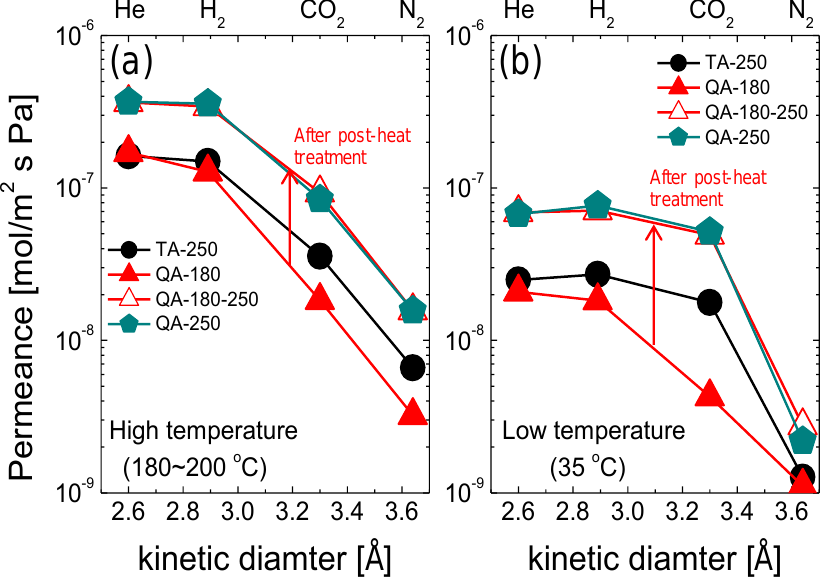
Figure 15. Kinetic diameter dependence of gas permeance for QA-Si derived membranes fired at different temperatures and performance comparison with TA-Si derived membranes at both ( a ) high and ( b ) low temperatures. Gas permeation test of QA-180 fabricated with a calcination temperature of 180 ◦ C was performed at 180 ◦ C and 200 ◦ C for the remaining three membranes. Reproduced from ref. [23] with permission. Copyright (2017), John Wiley and Sons.